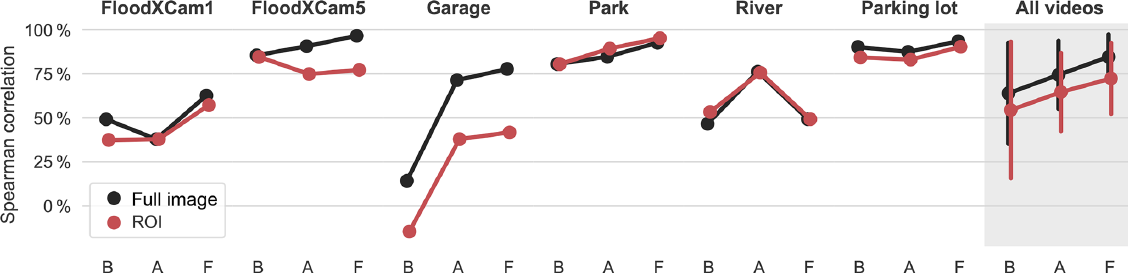
Figure 9. Spearman rank correlation coefficients for each video using the Basic (B), Augmented (A), and Fine-tuned (F) DCNNs. The final category All videos excludes the River video which is an outlier because the camera is intermittently submerged. The vertical segments in the All videos category represent the standard deviation of values. The results show that both the Augmented and Fine-tuned networks improve the correlation of SOFI with the water level, although performance is still